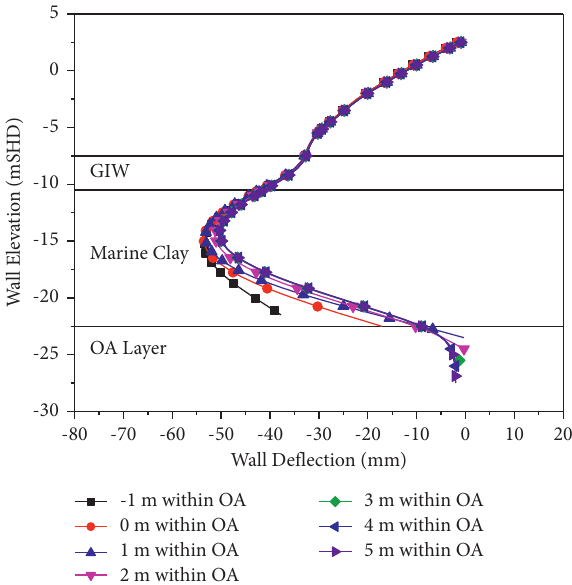
Figure 8: The effect of retaining wall embedded length into OA on wall deflection.